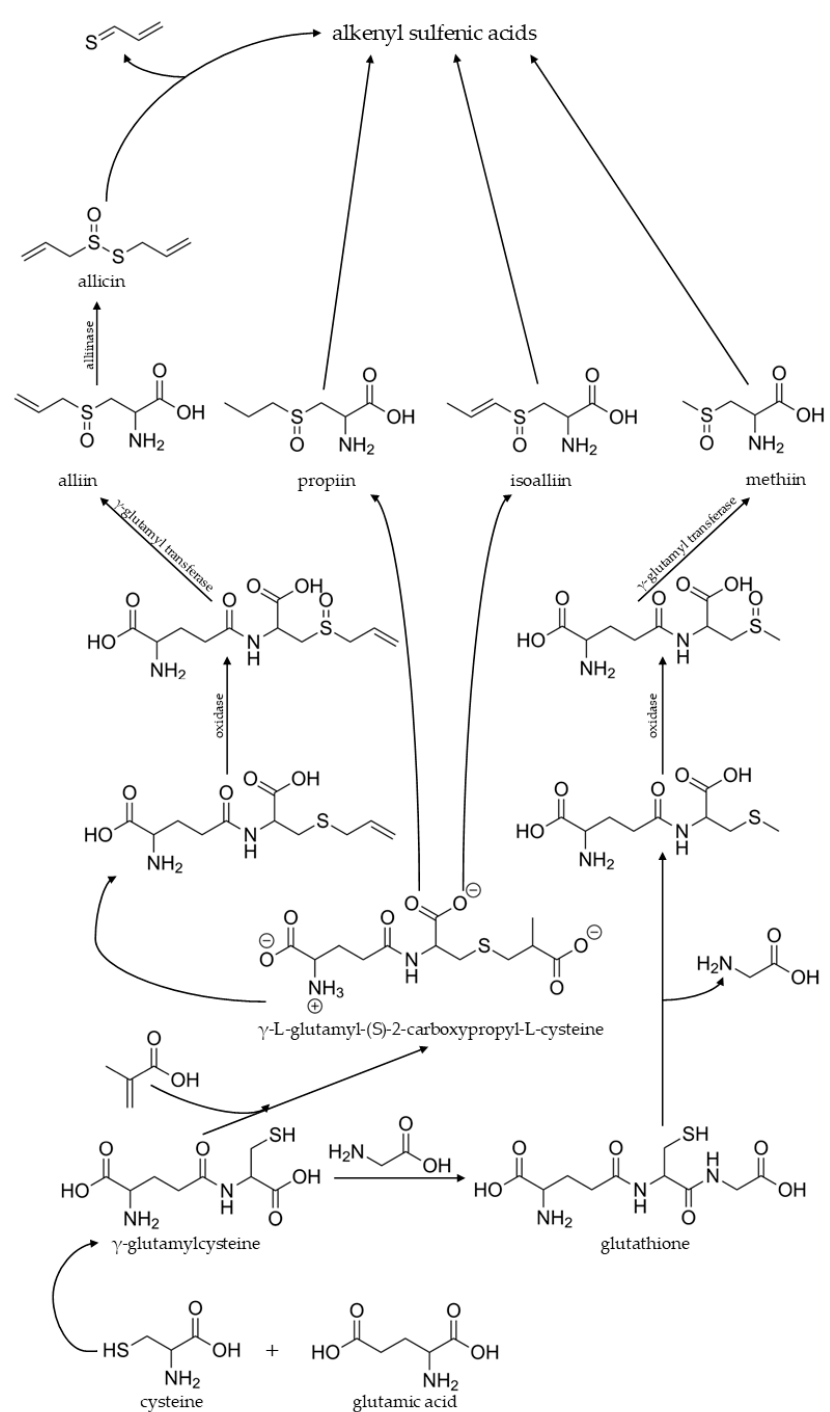
Figure 4. Initial stages of Allium flavor compounds formation by enzymatic reactions. Based on [47– 49,51] .